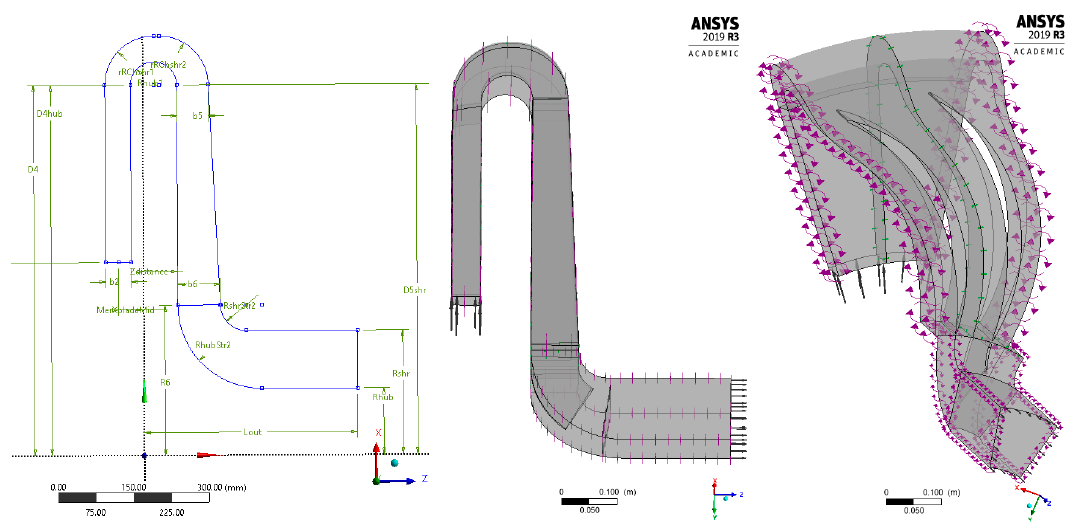
ψ = 0.60. Ф = 0.15 and des Tdes